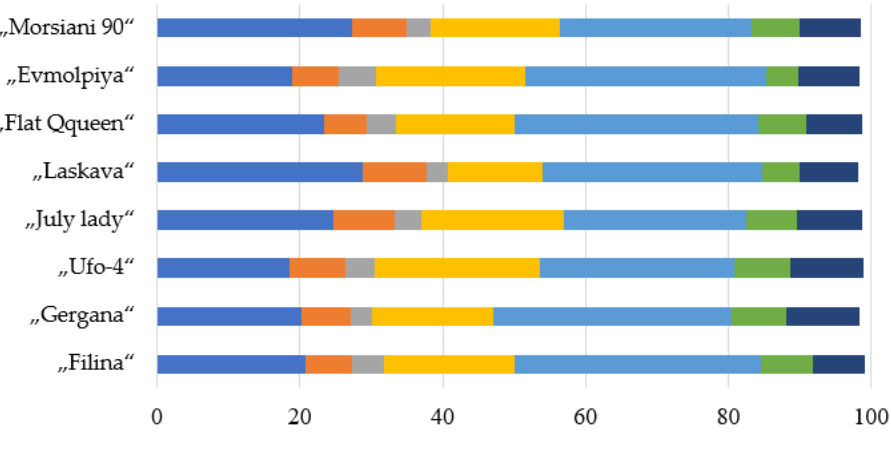
Figure 1. Distribution of volatile compounds according to their chemical families in the studied peach varieties.